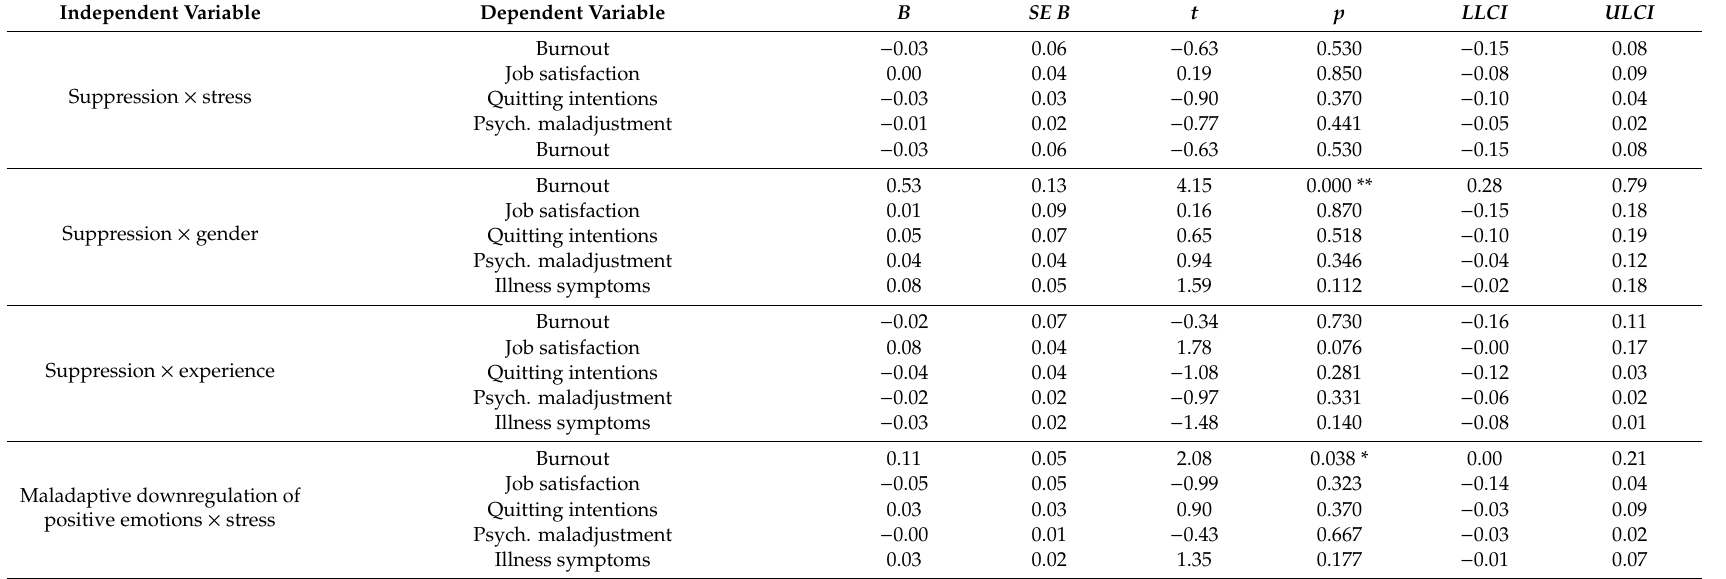
Table 7. Moderation Analyses for maladaptive Emotion regulation